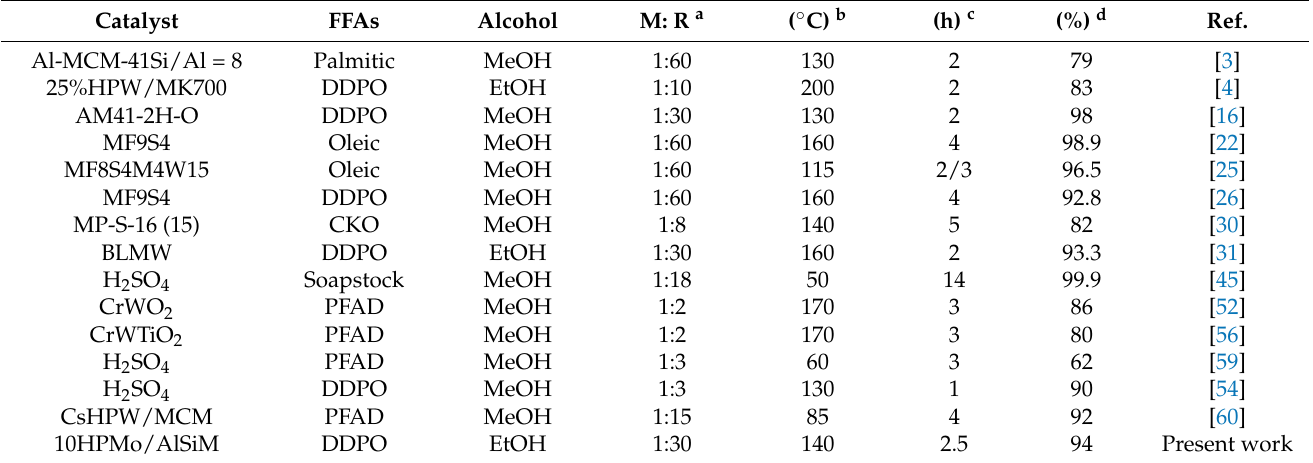
Table 1. Comparison of the catalytic activity of 10HPMo/AlSiM with other catalysts for the esterification of different free fatty